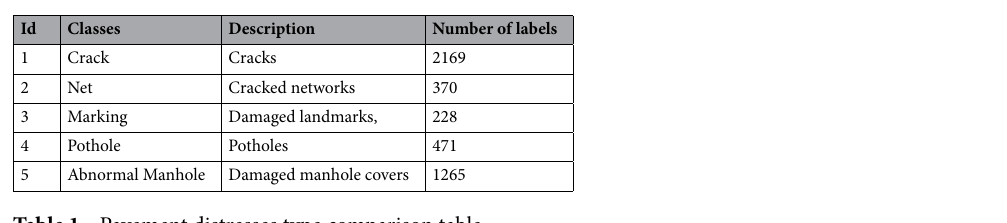
Table 1. Pavement distresses type comparison